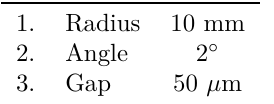
Figure 3. Crank-Slider